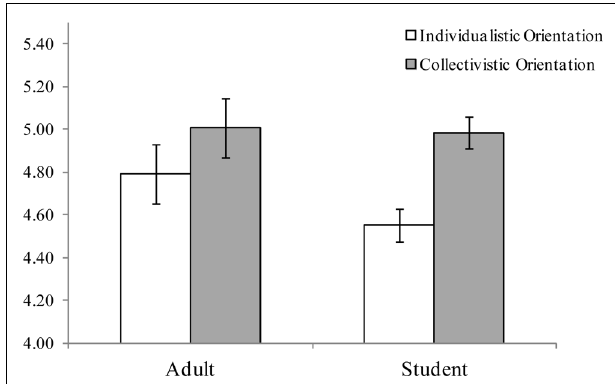
lower SWB and have fewer close friends. Thus, it is indicated